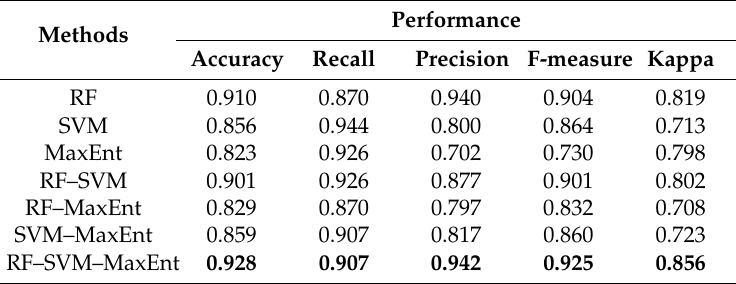
Table 1. Prediction accuracy of di ff erent methods on the